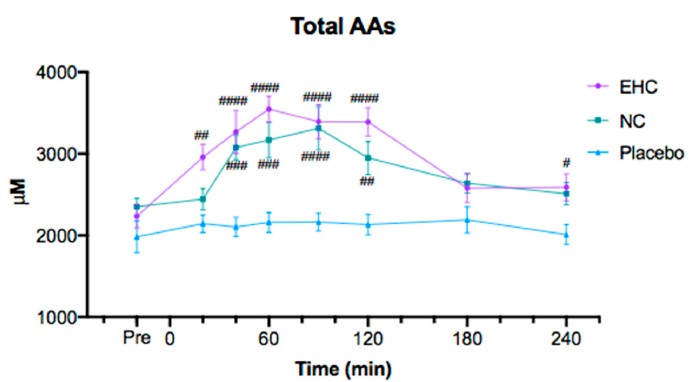
Figure 2. Plasma concentration of total amino acids (AAs). A significant di ff erence was observed between enzymatically hydrolyzed collagen (EHC) and placebo as well as between non-enzymatically hydrolyzed collagen (NC) and placebo, but not between the two collagen supplements. # p < 0.05, ## p < 0.002 ### p < 0.0002, #### p < 0.0001. All data are mean ± SEM. Table 3. Pairwise comparisons of dietary treatments for all amino acids (AAs). Comparison